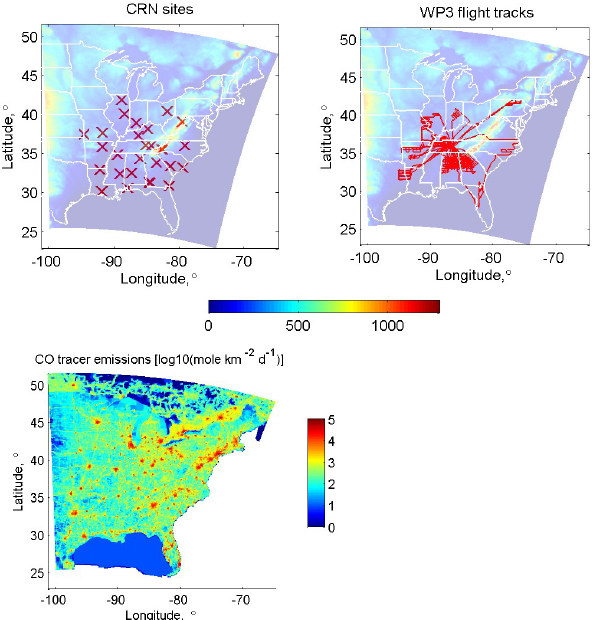
Figure 1: Maps of the WRF domain with terrain height (m ASL) colored as background and 535 Figure 1. Maps of the WRF domain with terrain height (ma.s.l.) colored as background and showing Climate Reference Network showing Climate Reference Network sites (upper left) and flight tracks of the NOAA WP3 (upper 536 sites (upper left) and flight tracks of the NOAA WP3 (upper right). right). Lower panel shows CO tracer emissions used in the FLEXPART-WRF runs. 537 Lower panel shows CO tracer emissions used in the FLEXPART- WRF